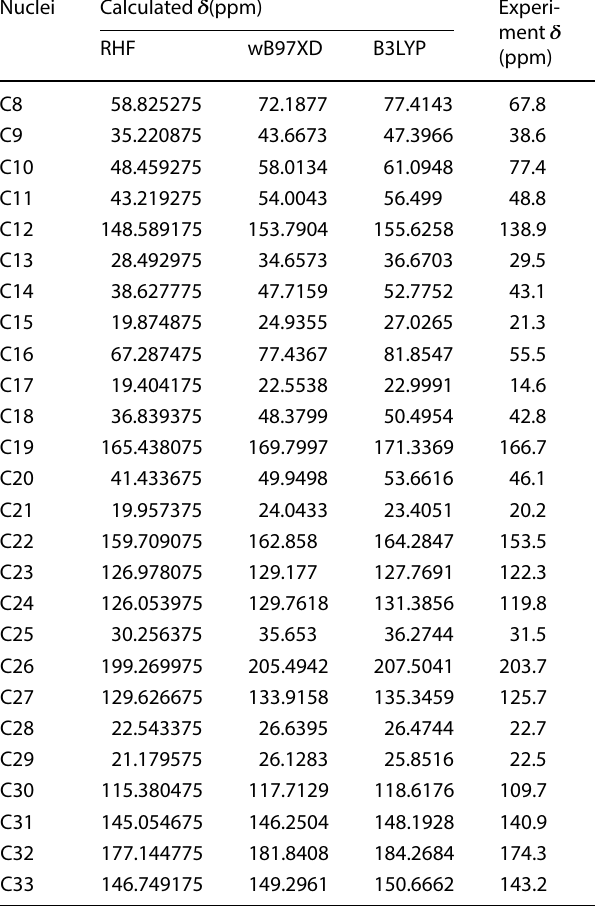
Table 3 Experimental [9] and calculated 13 C NMR chemical shift 𝛿 (ppm) of andirobin at the RHF, B3LYP and wB97XD method with 6–311 G(d,p) basis set Nuclei Calculated 𝜹 (ppm)